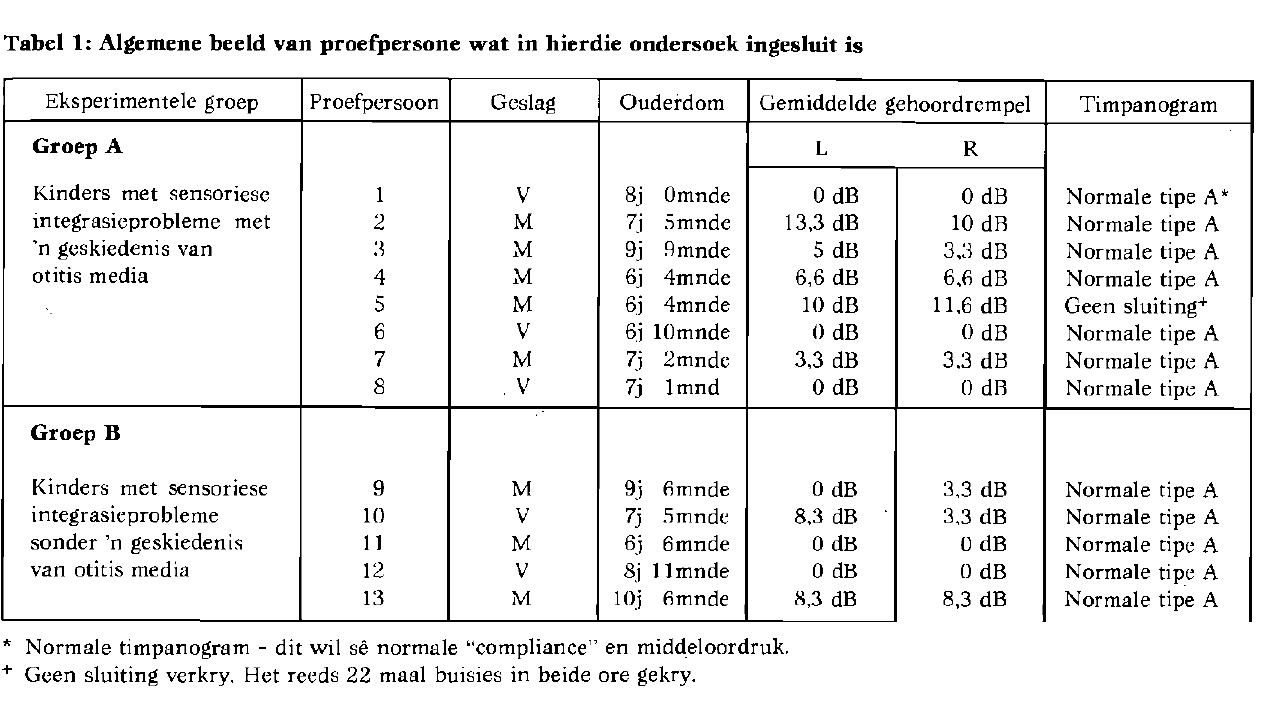
PROSEDURE Data-insameliny breer en voldoen aan die vereistes van SABS 0154-1979. Die eksperimentele toetsbattery was daarop gemik om die sentrale ouditiewe sisteem te evalueer en word in Tabel 2 verskaf. Tabel 2: Sentrale Ouditiewe Sisteem Toetsbattery Toets Motivering vir insluiting by